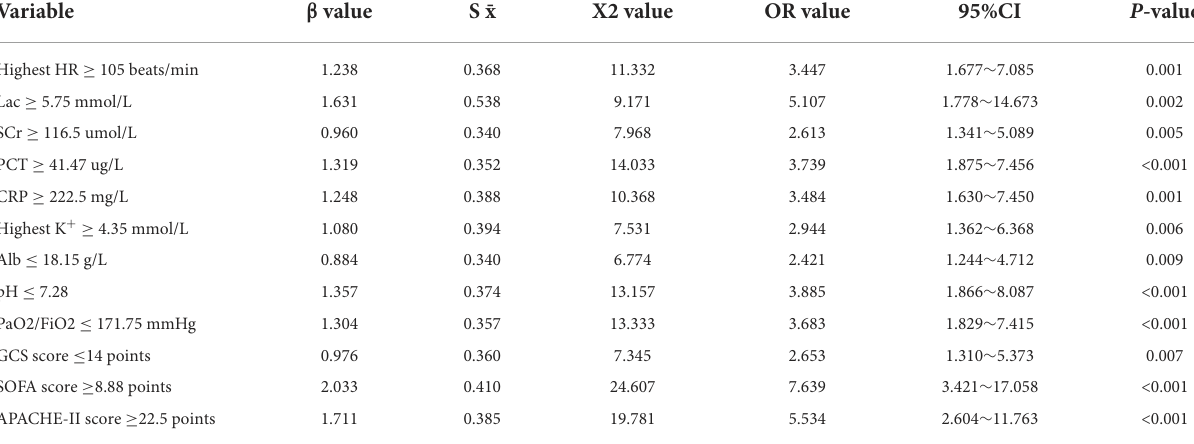
TABLE 3 Univariate logistic regression analysis on the occurrence of septic